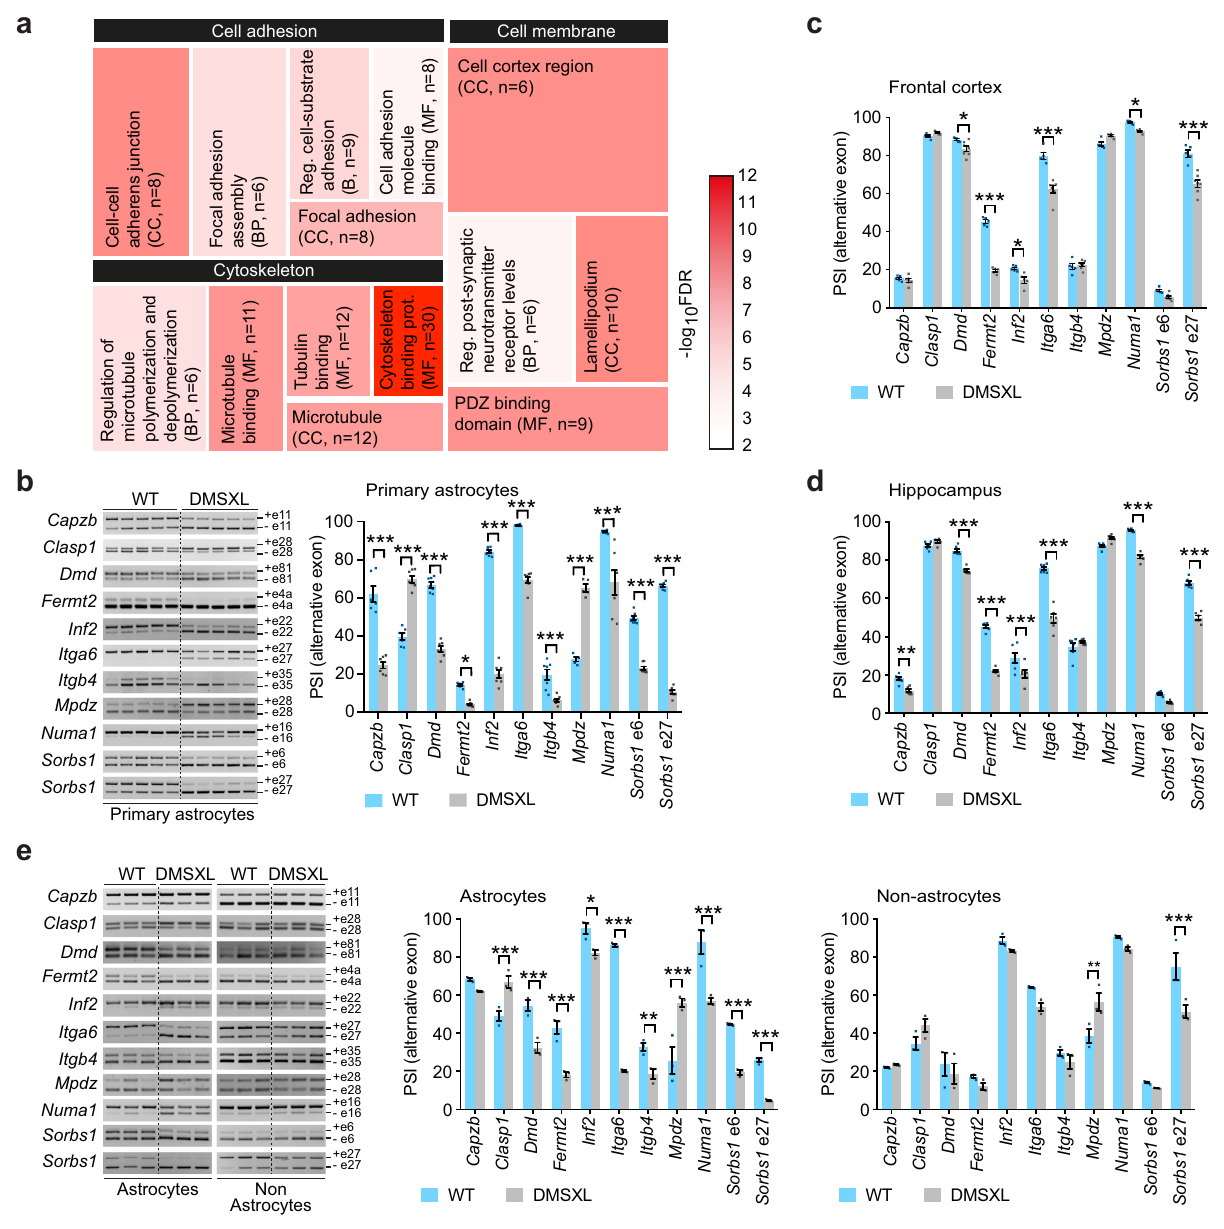
Fig. 7 RNA sequencing of primary DMSXL astrocytes indicates defects in cell adhesion, cytoskeleton and cell membrane. a Tree map representation of enriched non-redundant GO terms associated with the abnormally spliced genes in primary DMSXL astrocytes, and distributed by three main categories. Cell sizes are proportional to the enrichment ratio of each GO term. The heatmap scale represents the − log 10 (FDR) of enrichment. BP, biological process. CC, cellular component. MF, molecular function. The number of misspliced genes (n) in each category is shown. b Representative RT-PCR splicing analysis of selected transcripts that regulate cell adhesion and cytoskeleton in primary DMSXL and WT astrocytes. Alternative exons are indicated on the right. The graph represents the PSI of alternative exons. Data are means± SEM, n = 5 – 7 independent cultures per genotype ( p < 0.0001, Capzb, Clasp1, Dmd, Inf2, Itga6, Mpdz, Numa1, Sorbs1 e6, Sorbs1 e27; p = 0.0122, Fermt2 ; p = 0.0001, Itgb4 ; Two-way ANOVA, Sidak post hoc test for multiple comparisons). c Splicing dysregulation of adhesion- and cytoskeleton-associated transcripts in DMSXL frontal cortex. Data are means ± SEM, n = 5 – 7 mice per genotype ( p = 0.7944, Capzb , Itgb4 ; p = 0.7258, Clasp1 ; p = 0.0338, Dmd ; p < 0.0001, Fermt2 , Itga6 , Sorbs1 e 27; p = 0.0093, Inf2 ; p = 0.0859, Mpdz ; p = 0.0405, Numa1 ; p = 0.1429, Sorbs1 e6; Two-way ANOVA, Sidak post hoc test for multiple comparisons). d Splicing dysregulation of adhesion- and cytoskeleton- associated transcripts in DMSXL hippocampus. Data are means± SEM, n = 6 mice per genotype ( p = 0.0051, Cpazb ; p = 0.8999, Clasp1 ; p < 0.0001, Dmd , Fermt2 , Inf2 , Itga6 , Numa1 , Sorbs1 e27; p = 0.7844, Itgb4 ; p = 0.1630, Mpdz ; p = 0.0916, Sorbs1 e6; Two-way ANOVA, Sidak post hoc test for multiple comparisons). e Representative RT-PCR splicing analysis in forebrain astrocytes and non-astrocyte cells isolated from 1-month-old mice. PSI of alternative exons in astrocytes and non-astrocyte cell fractions. Data are means ± SEM, n = 3 mice per genotype (Astrocytes: p = 0.7686, Capzb ; p = 0.0005, Clasp1